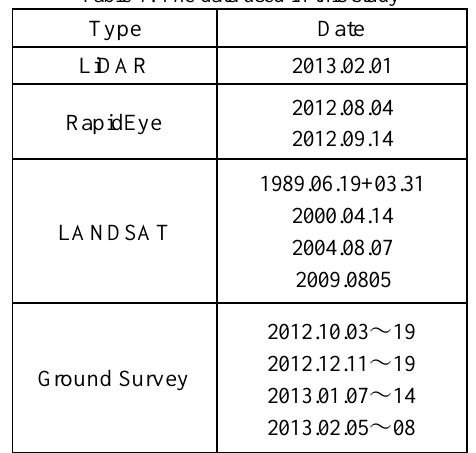
Figure 3. Steps of